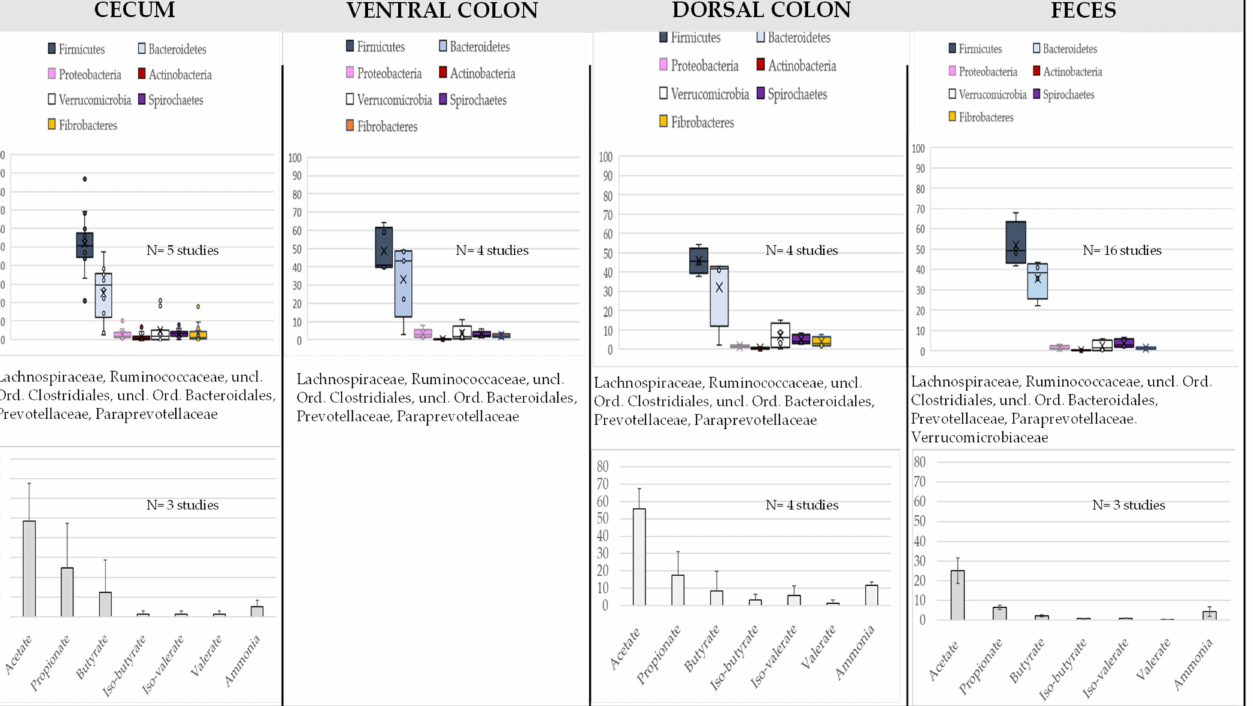
Figure 2. Main phyla and families (relative abundance, %) present in the lower tract of healthy adult horses and concentrations of the main organic acids found (expressed in